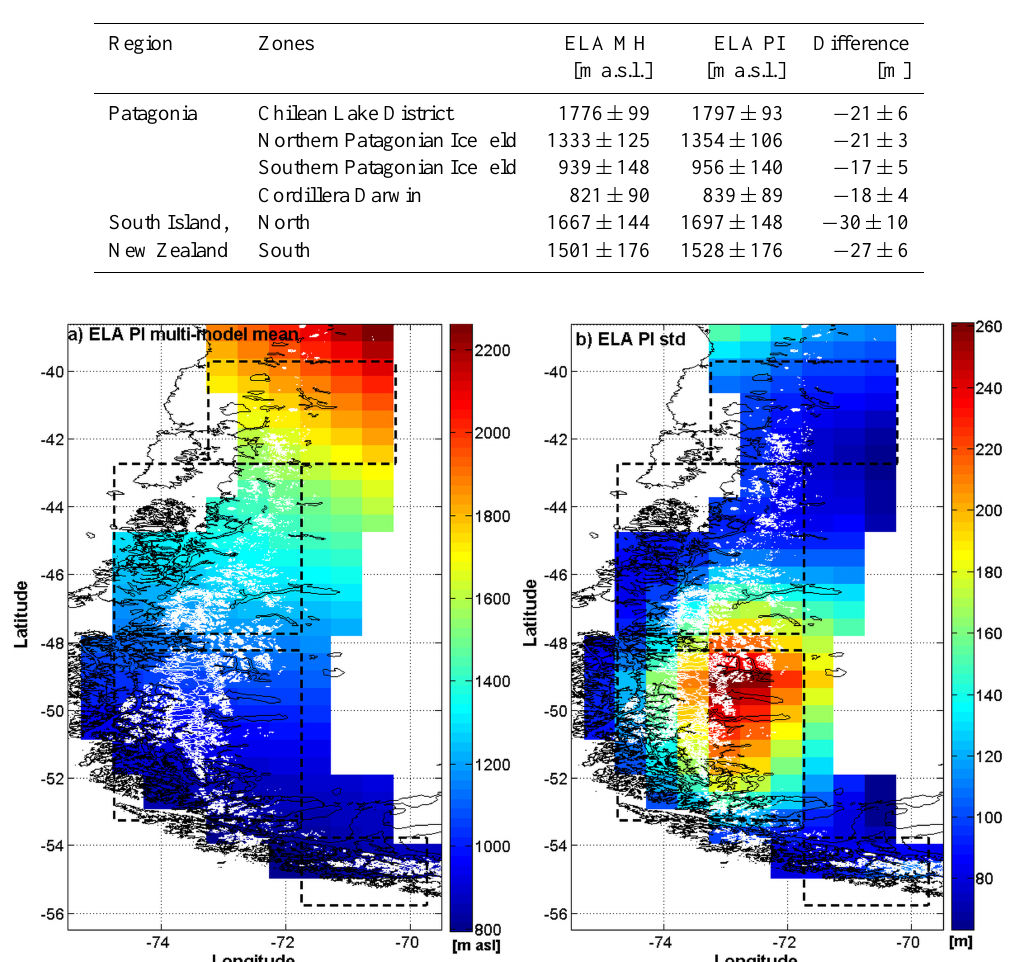
Figure 4. Spatial distribution of pre-industrial equilibrium line altitude (ELA) in South America based on six PMIP2 simulations. (a) Mean ELA (ma.s.l.) and (b) inter-model variability of the ELA (1 standard deviation). White lines correspond to actual glacier extension according to the Randolph Glacier Inventory (RGI